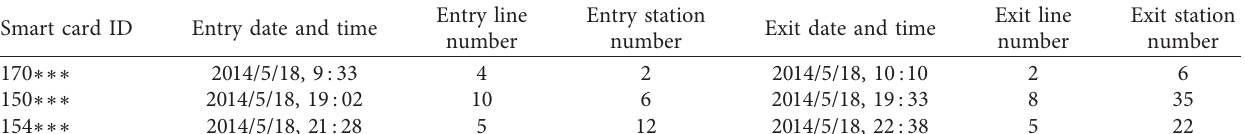
Table 1: Result examples of the Beijing Subway AFC system data